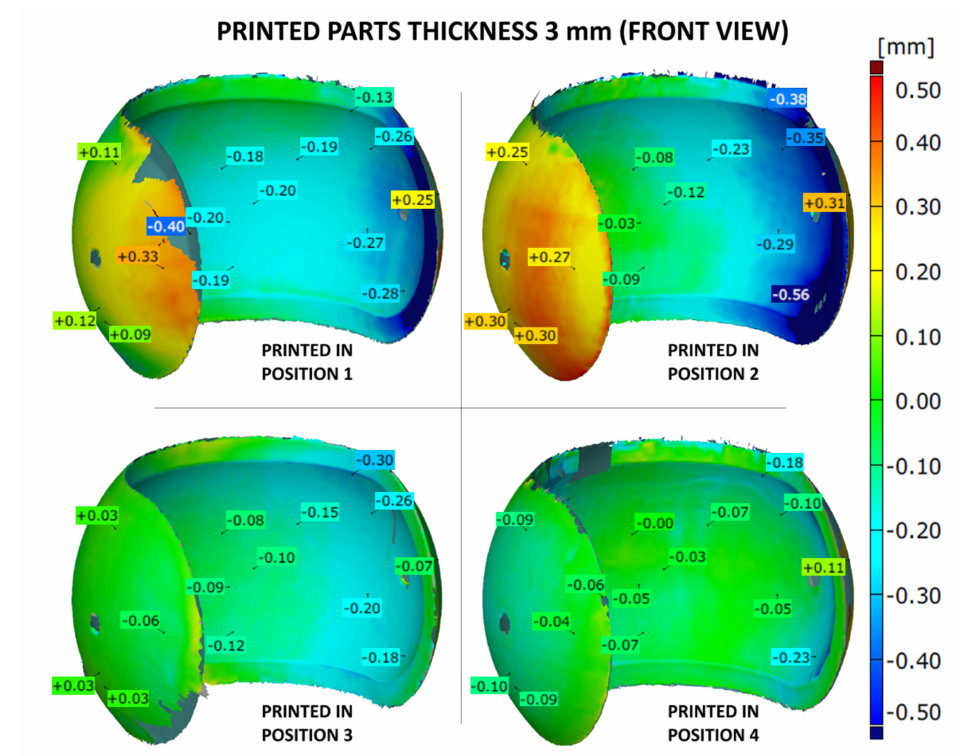
Figure 11. Geometry deviations of the 3D printed part with a thickness of 3 mm (front